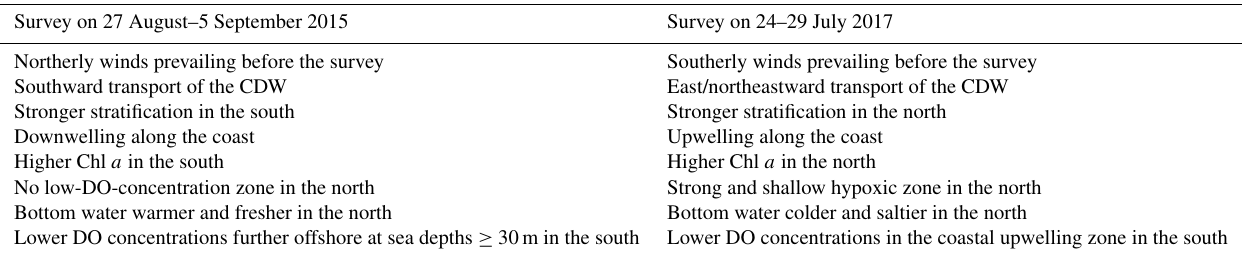
Table 1. Summary of general features observed in the study area in summers 2015 and